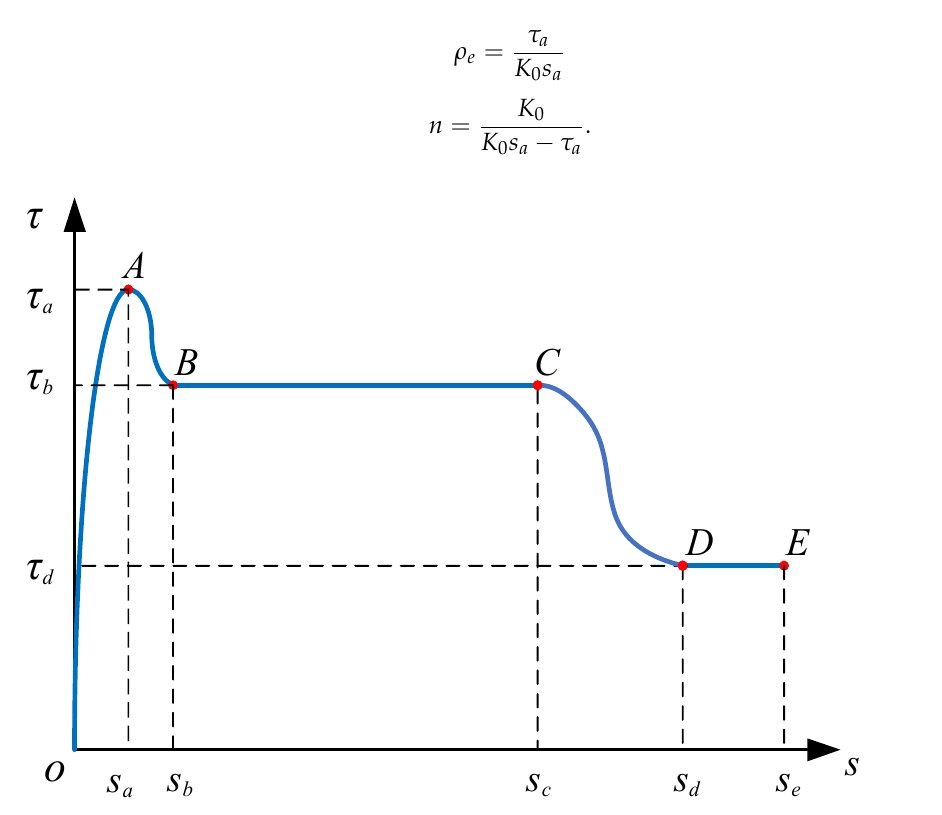
Figure 6. The typical bond–slip model for steel strand mesh and ECC.